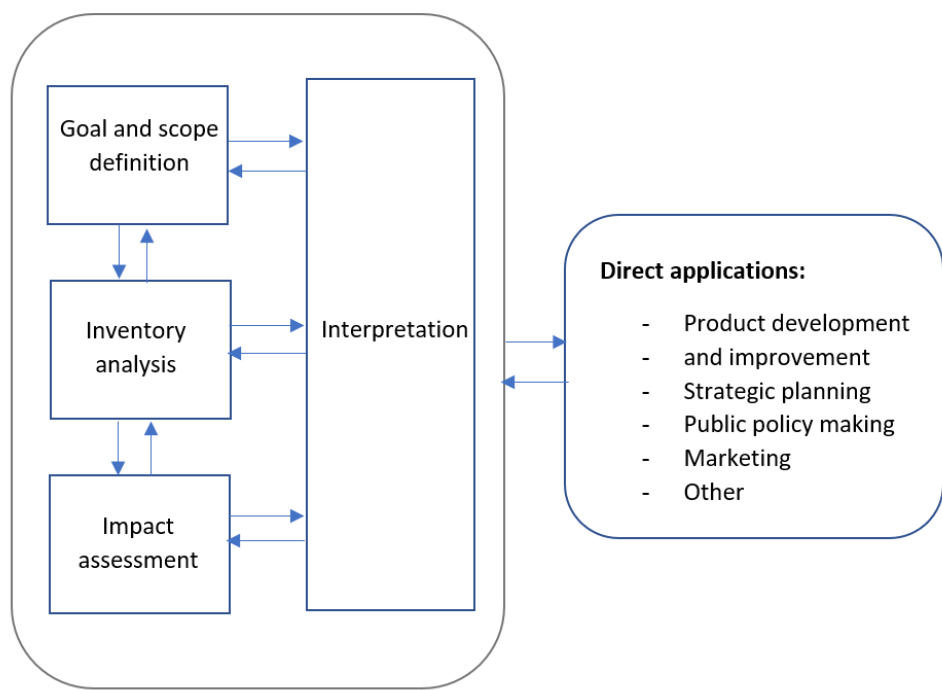
Figure 1. Life cycle assessment (LCA) phases according to ISO standards [11].